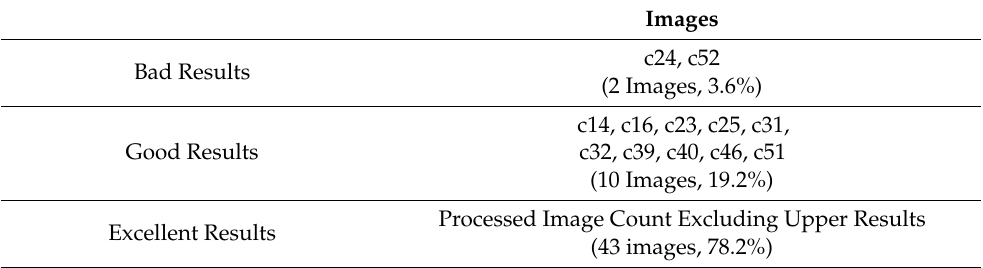
Table 10. Summary of crack images.